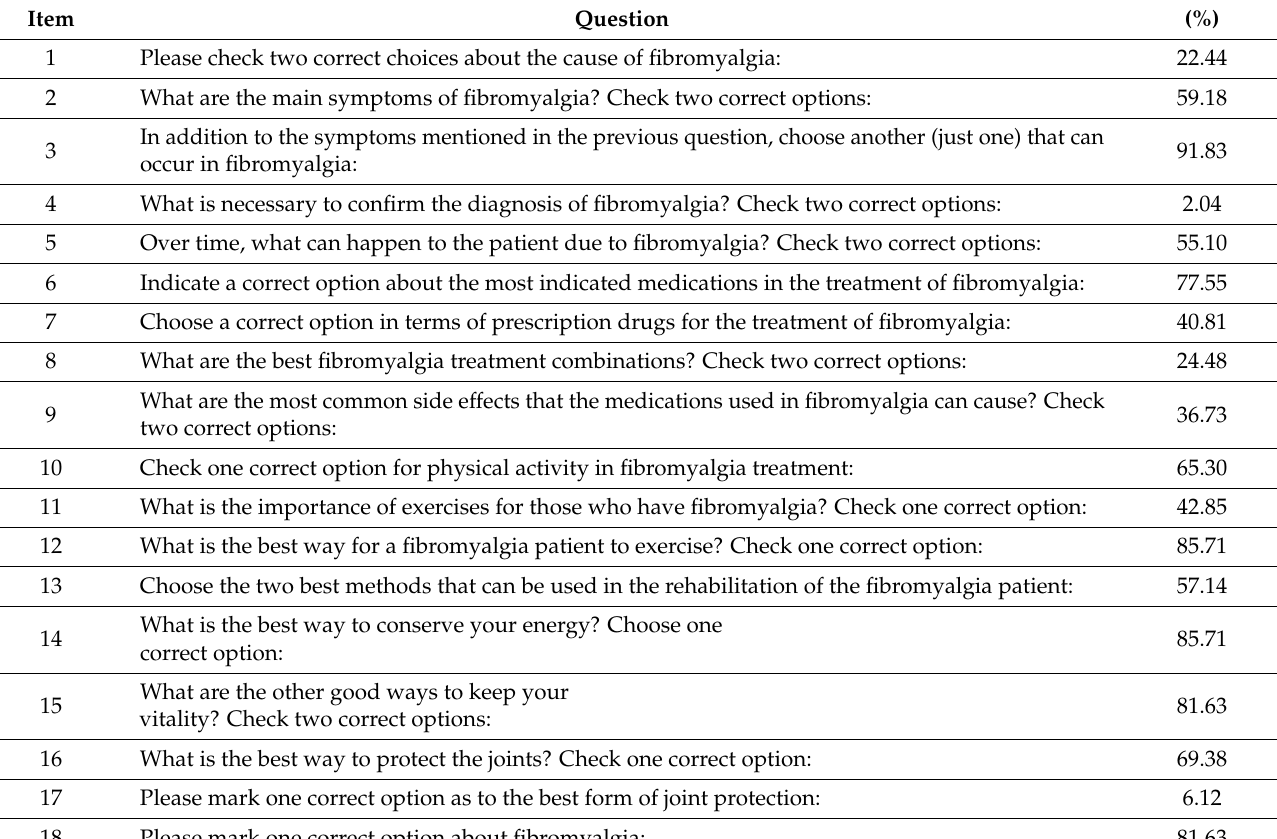
Table 5. Frequency of correct answers about the FKQ.